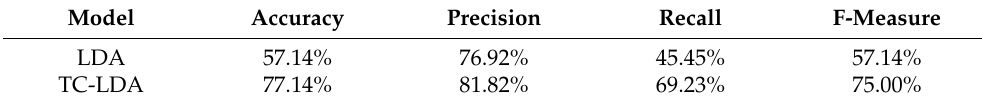
Table 5. Performance comparison between LDA model and TC-LDA model. Model Accuracy Precision Recall